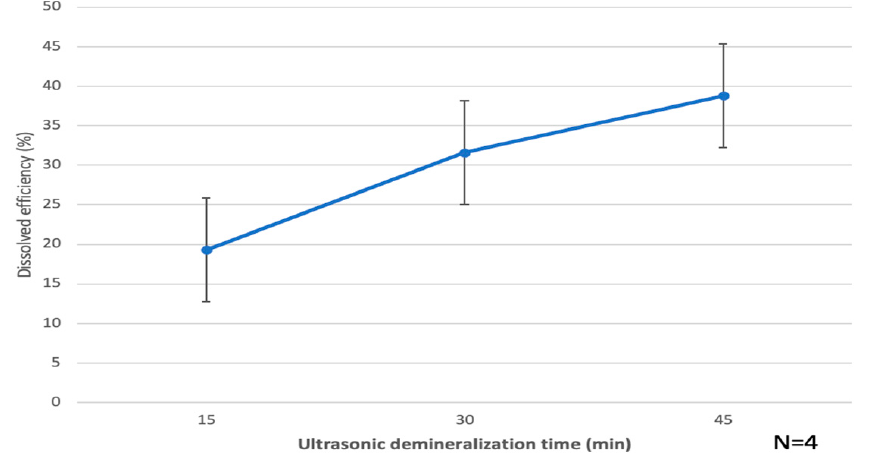
Figure 4. Dissolved efficiency of CDM blocks by ultrasonic demineralization in 1.0 L of 2% HNO 3 solution. Demineralized dentin for 30 minutes: named as PDDM. CDM: Calcified dentin matrix, PDDM: Partially demineralized dentin matrix.